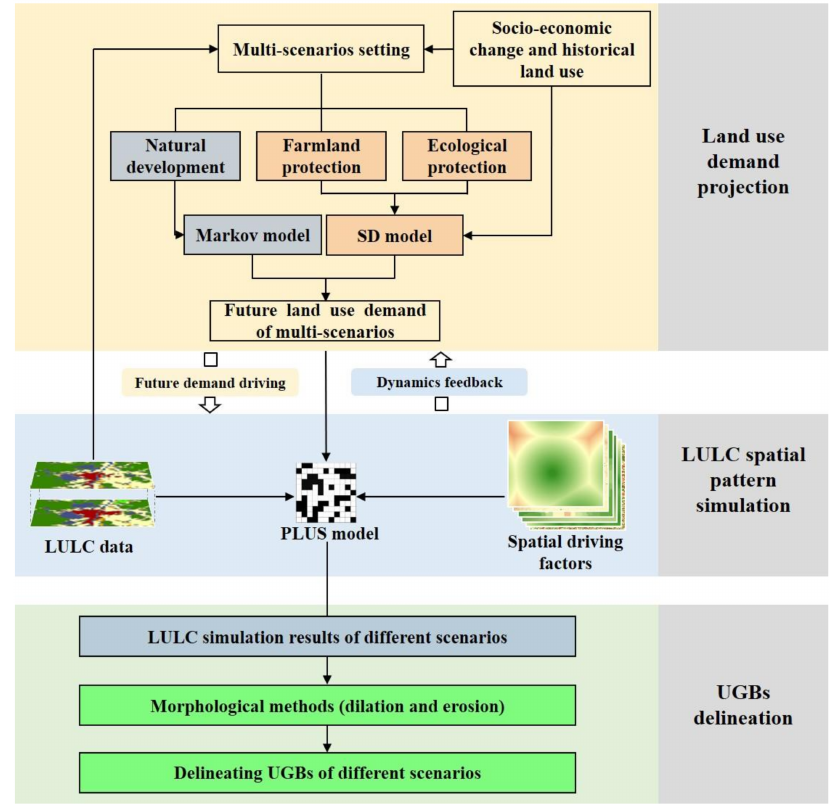
Figure 3. The flowchart of the proposed